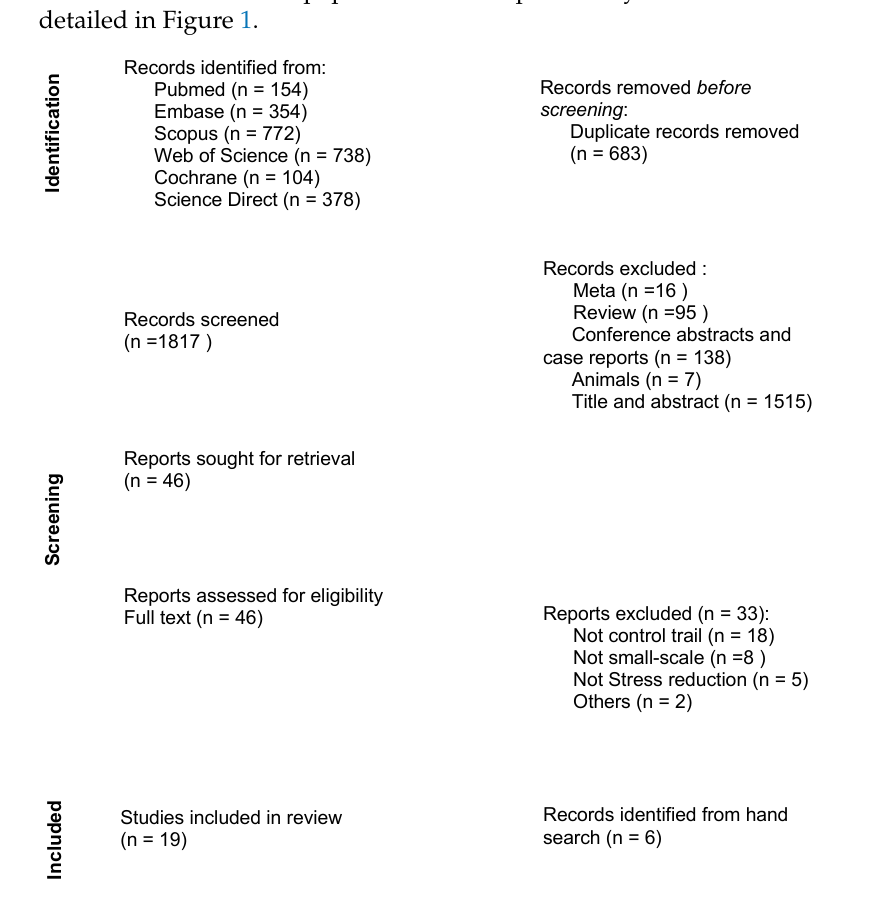
Figure 1. Flow diagram of the study selection process.